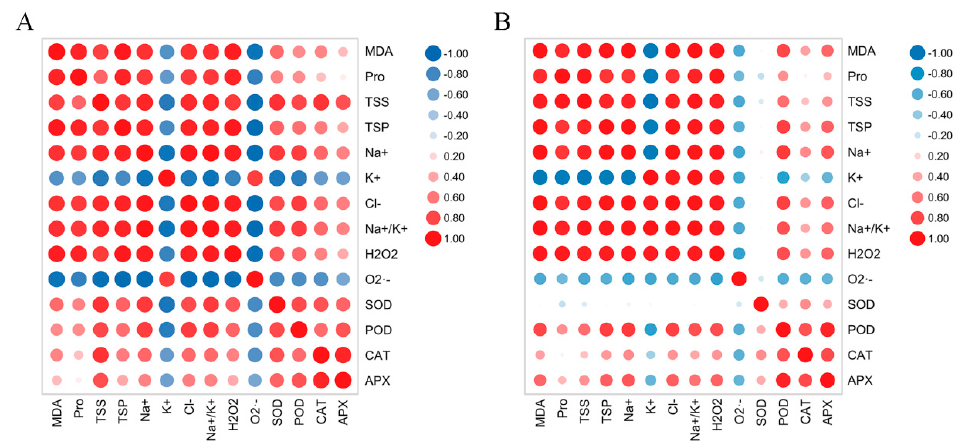
Figure 7. Correlation coefficients between physiological parameters, oxidative stress markers, and antioxidant capacity in ( A ) H. syriacus ‘Duede Brabaul’ (DB) and ( B ) H. syriacus ‘Blueberry Smoothie’ (BS) leaves. Plants were grown for 12 days at 5 salinity levels (0, 50, 100, 150, and 200 mM NaCl). Note: MDA, malondialdehyde; Pro, proline; TSS, total soluble sugars; TSP, total soluble protein; Na + , sodium ions; K + , potassium ions; Cl − , chloride ions; Na + /K + , sodium-to-potassium ion ratio; H 2 O 2 , hydrogen peroxide; O 2 · − , inhibition of O 2 · − product activity; SOD, superoxide dismutase; POD, peroxidase; CAT, catalase; APX, ascorbate